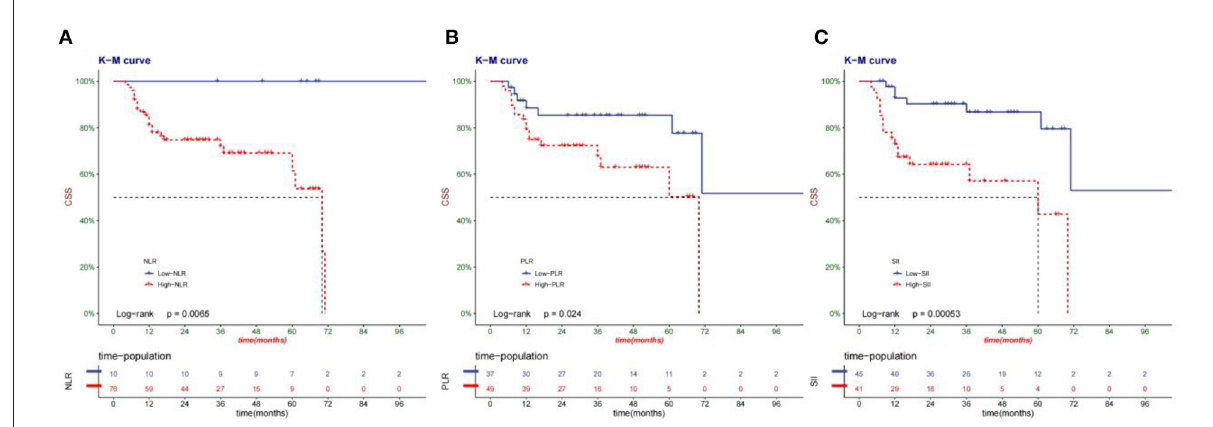
FIGURE3 Kaplan-Meier curve of the CSS of patients according to NLR (A) , PLR (B) , and SII (C) group.